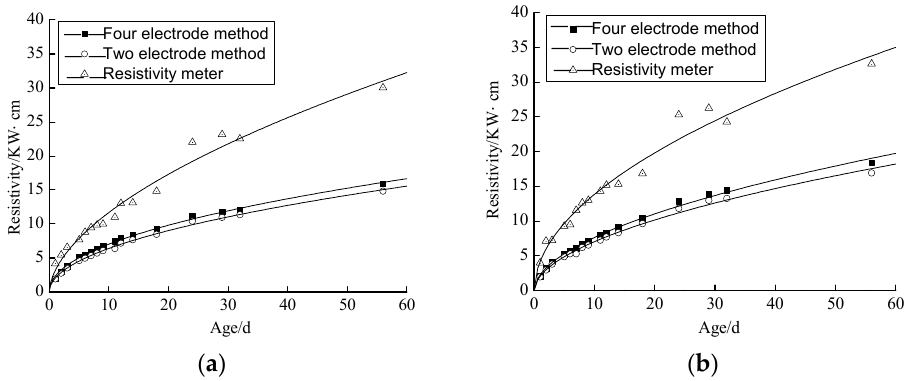
Figure 15. The resistivity of the CMA_0 and CMA_Cgroups: ( a ) CMA_0; ( b ) CMA_C.